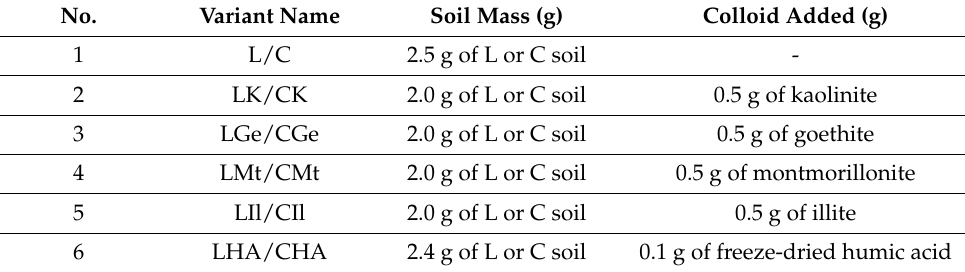
Table 3. Composition and labelling of the studied experimental variants.